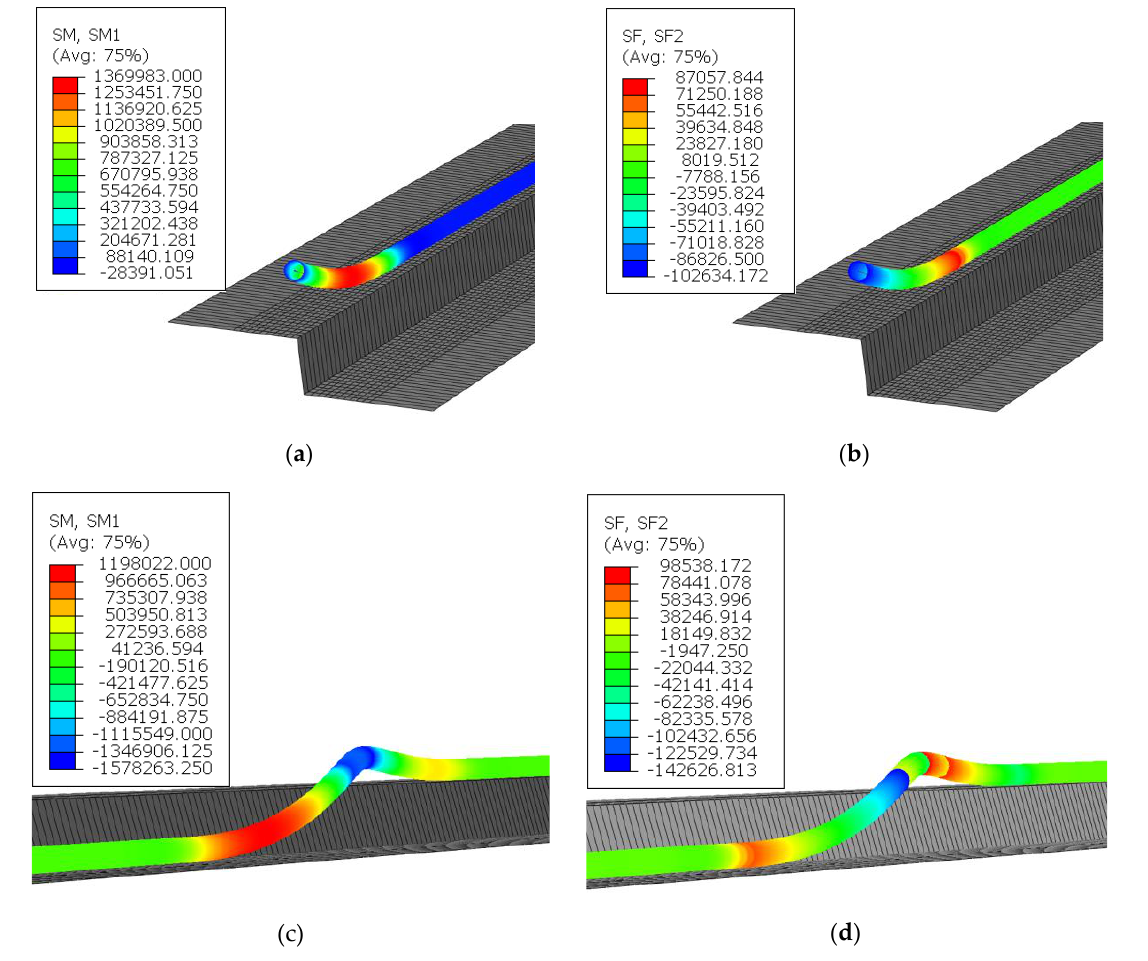
Figure 7. Sectional forces of FE model (rendering contour): ( a ) bending moments for Model 1 (unit : N · m); ( b ) shear forces for Model 1 (unit : N); ( c ) bending moments for Model 2 (unit : N · m); ( d ) shear forces for Model 2 (unit : N).